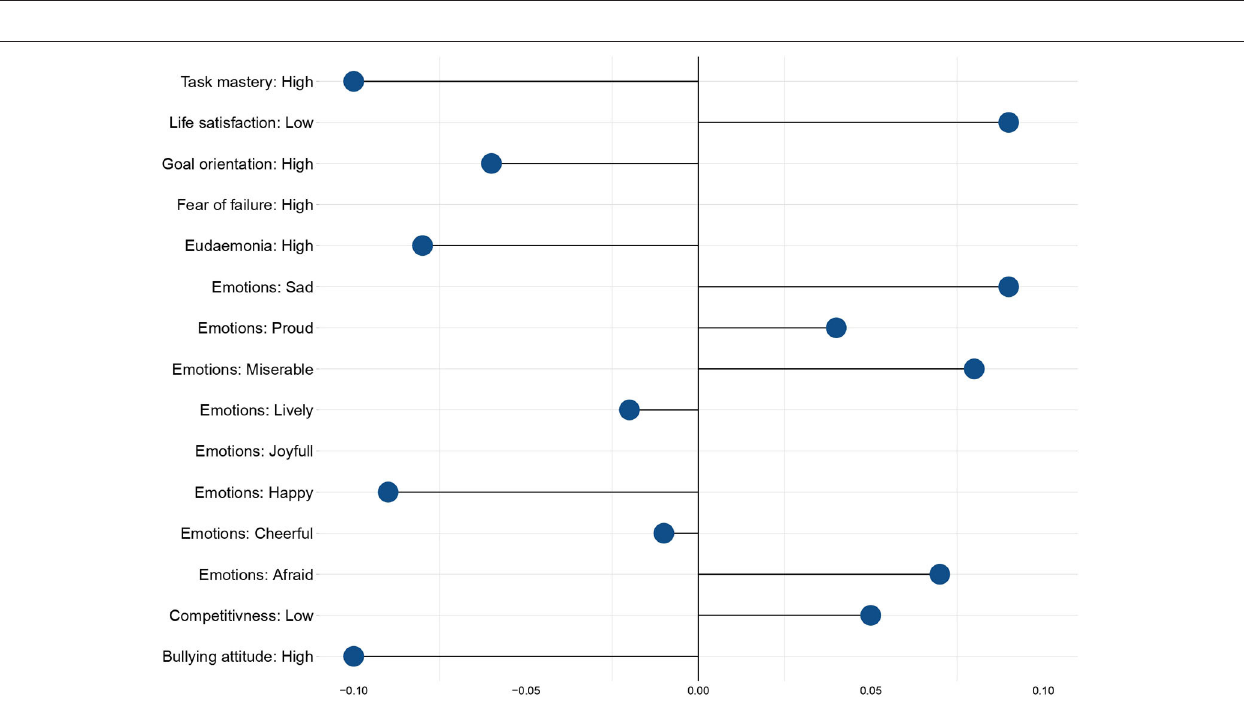
FIGURE 4 | Marginal effects of bullying on the emotional states and psychosocial traits of the victims. Source: Calculations of the authors based on PISA-2018 in Russia.